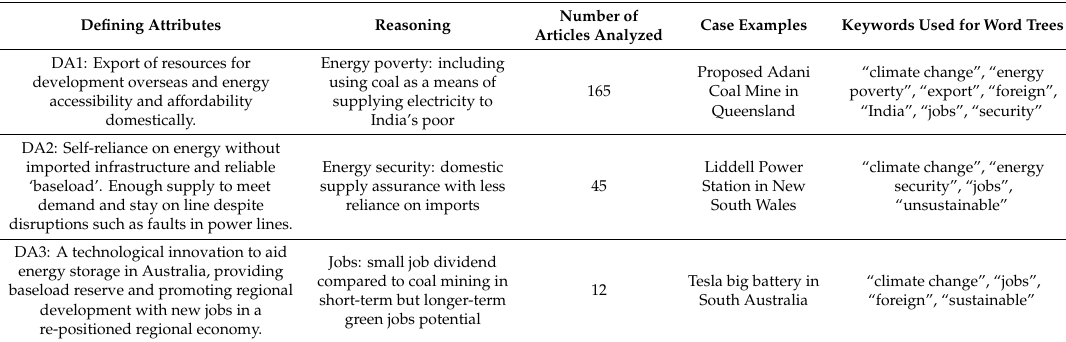
Table 1. Defining attributes, dataset, case description and analytical criteria of the media